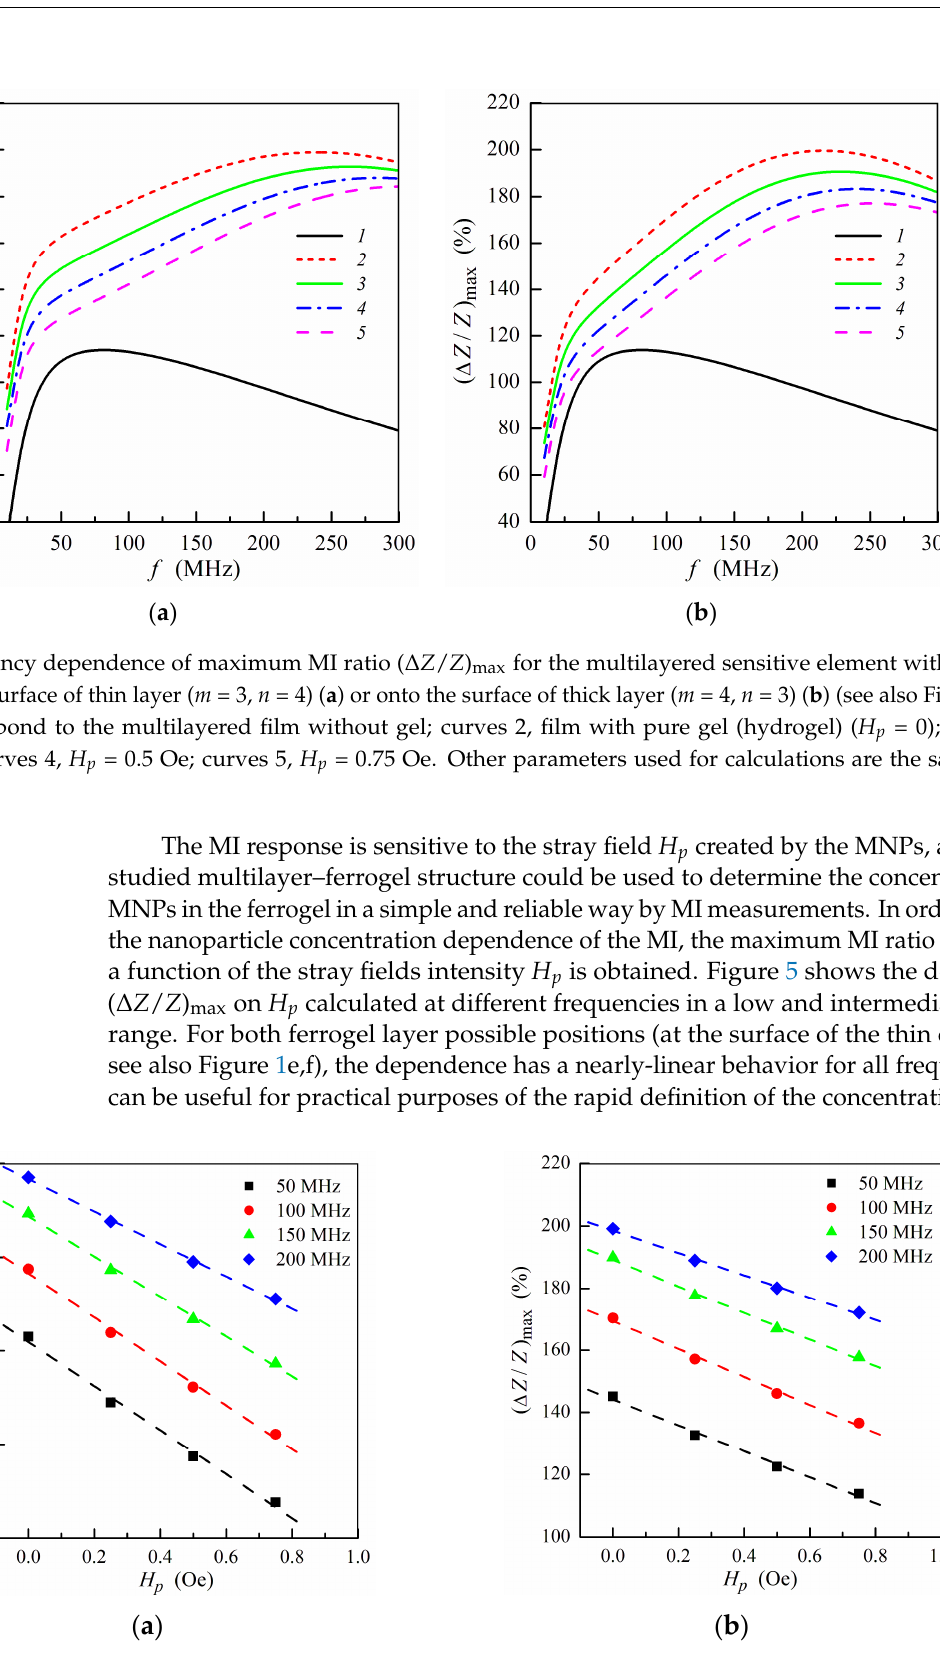
Figure 3. Frequency dependence of maximum MI ratio ( Δ Z / Z ) max : curve 1, multilayered film with- out gel; curve 2, multilayer with pure gel (hydrogel) placed onto the surface of thin layer ( m = 3, n = 4); curve 3, multilayer with pure gel placed onto the surface of thick layer ( m = 4 , n = 3 ) (see also Figure 1e,f). Other parameters used for calculations are the same as in Figure 2.